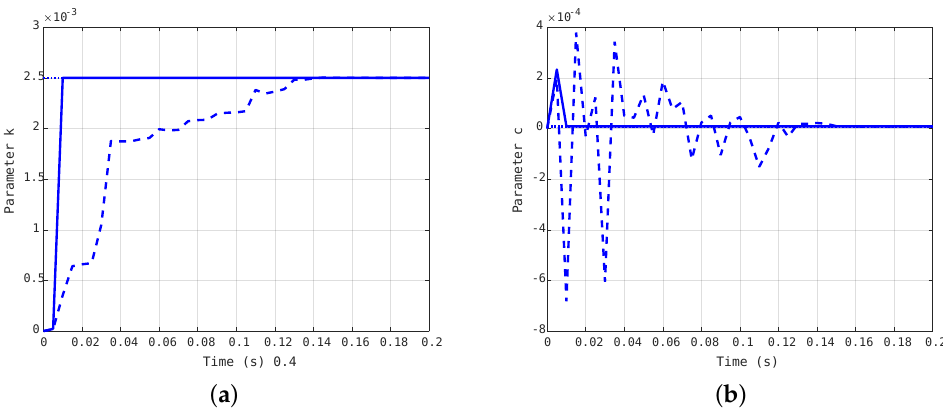
Figure 4. Time evolution of the estimated parameters k ( a ) and c ( b ) for the first case: c = 8.4 × 10 − 6 Nms/rad, k = 2.5 × 10 − 3 Nm/rad.